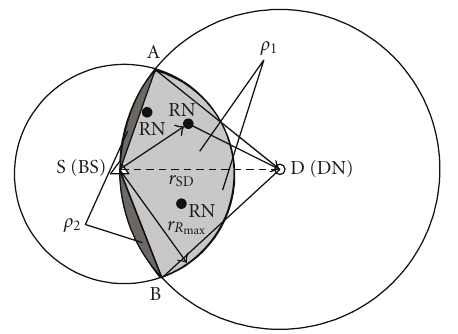
Figure 7: Illustration of areas where RN is capable of receiving with R max